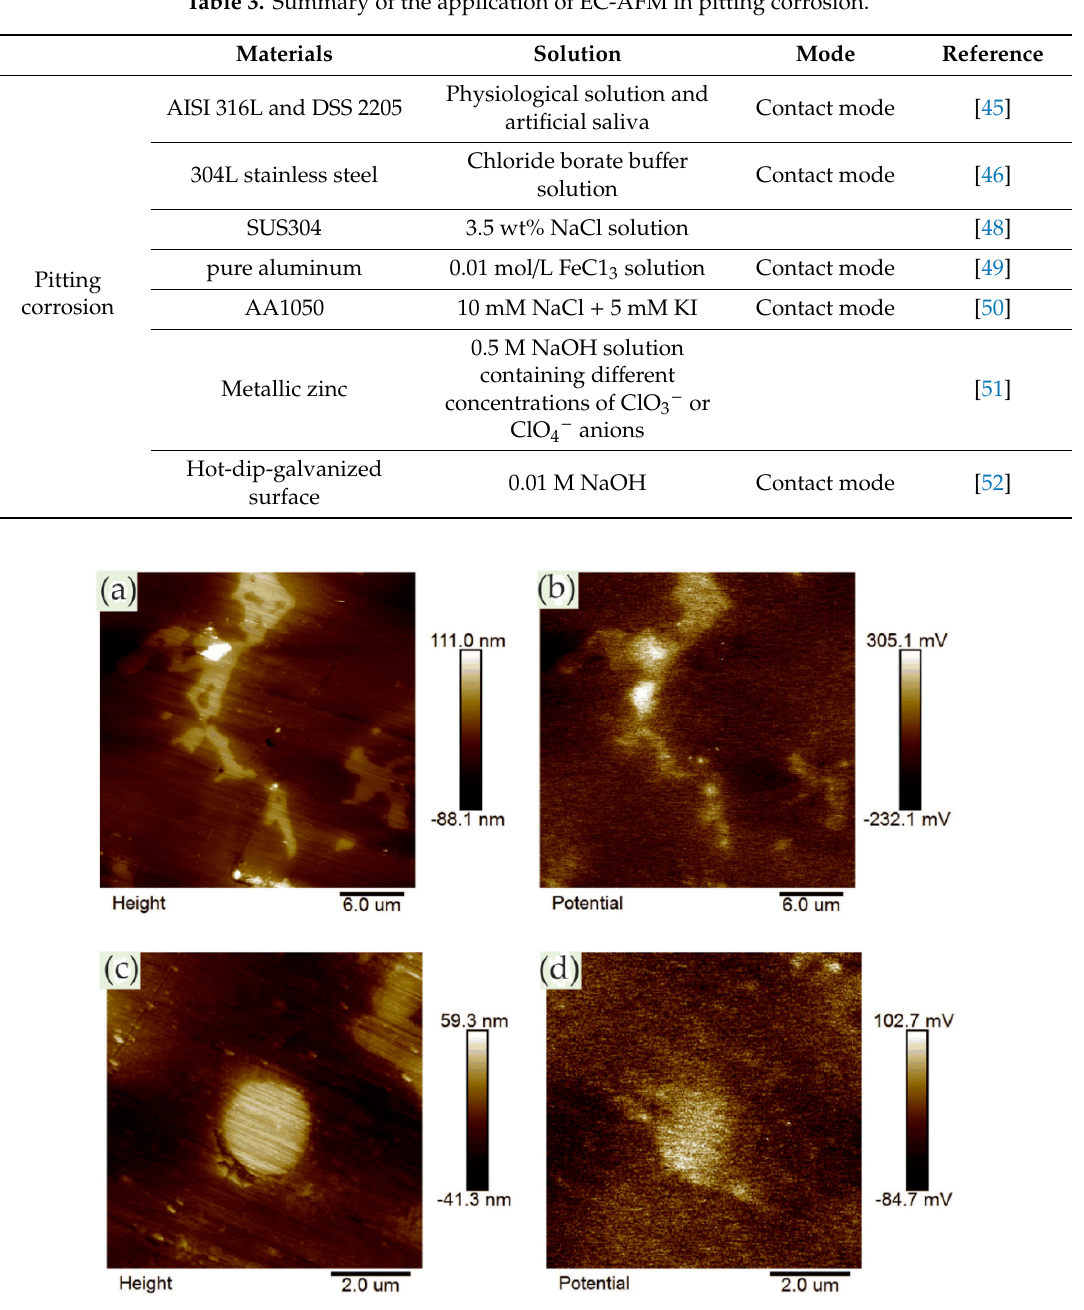
Table 3. Summary of the application of EC-AFM in pitting corrosion.